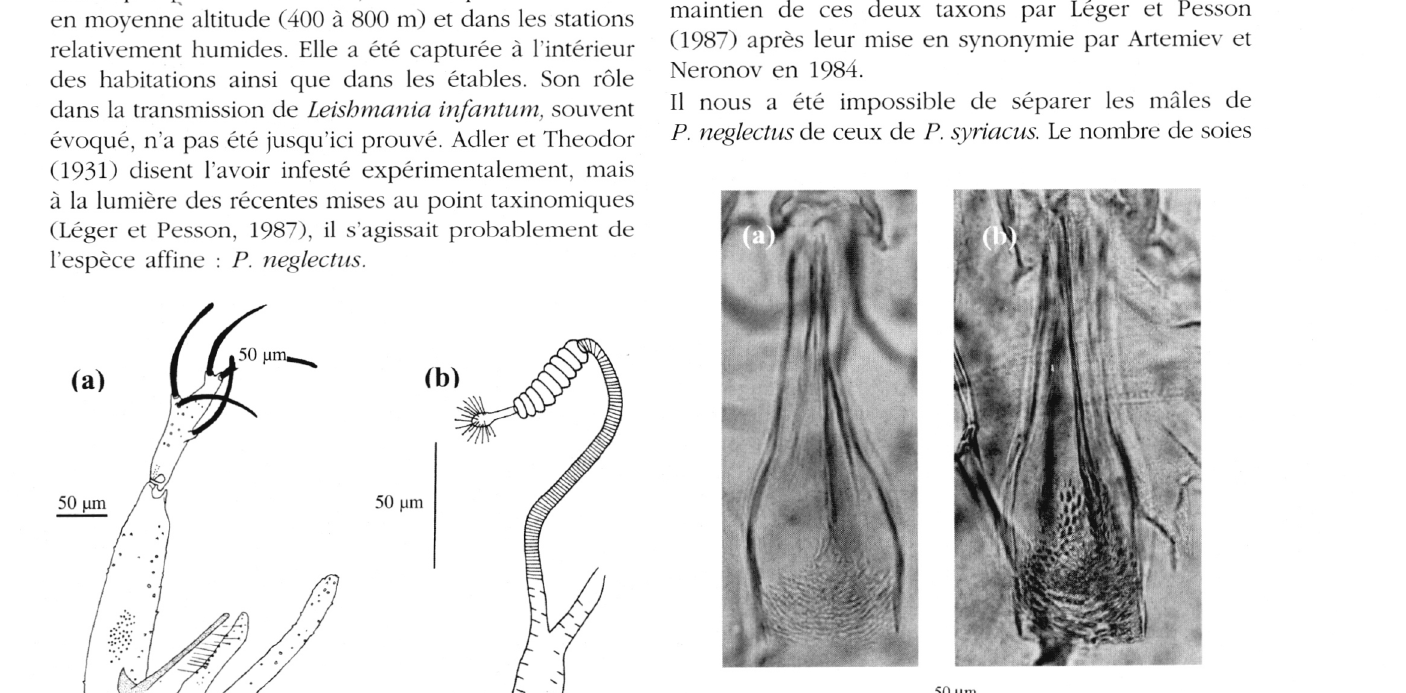
Fig. 2. - Armature pharyngienne femelle : P. syriacus (a ; P.